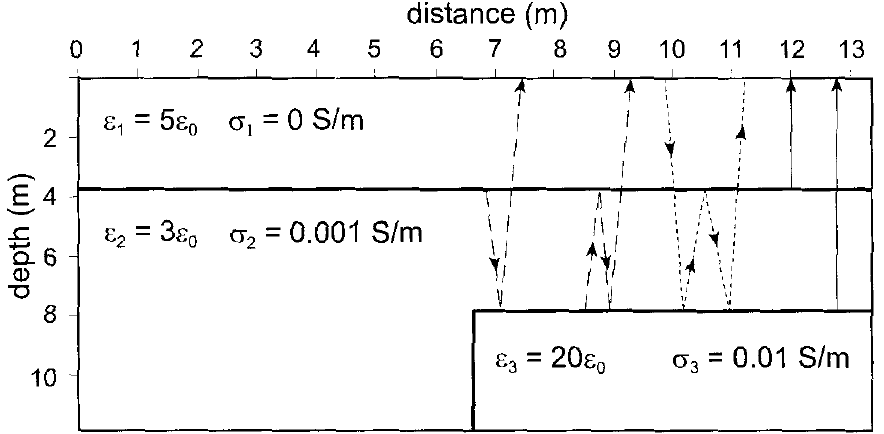
Fig. 1. Model and electromagnetic properties. The ray-paths represented with solid lines are the direct arrivals. The dotted line is a physical multiple. The dashed lines represent non-physical multiple events due to the presence of down-going waves in the exploding-reflector experiment (Carcione et al.,